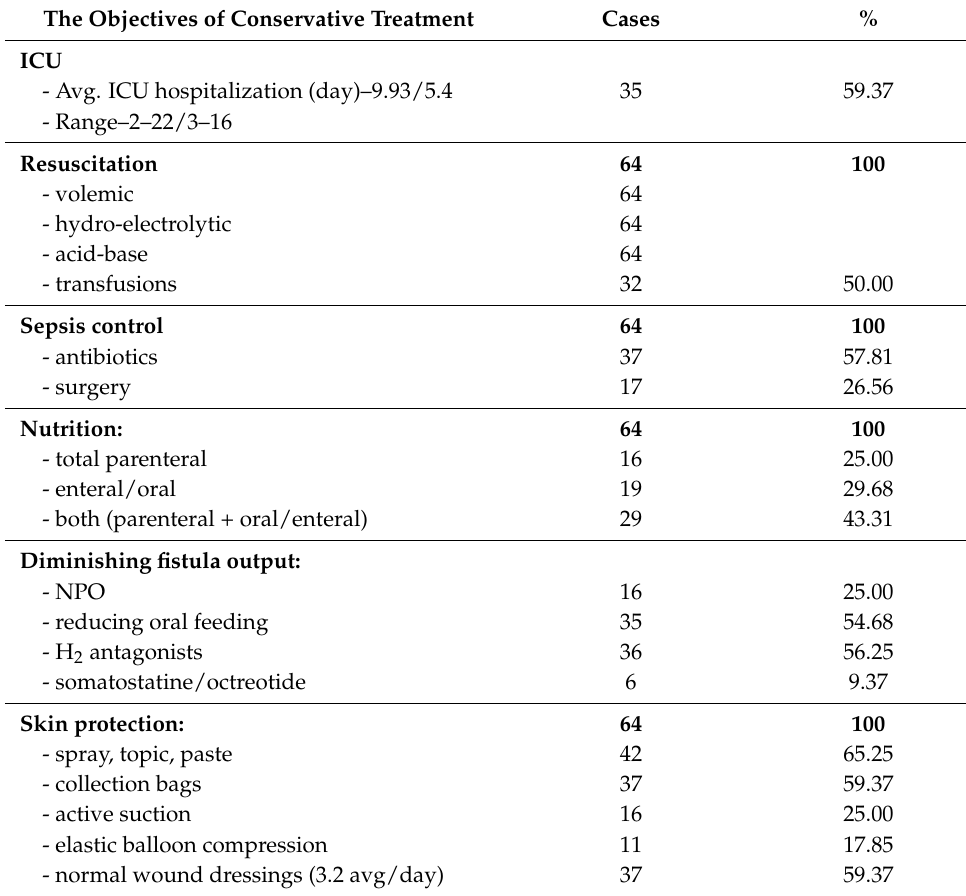
Table 1. Conservative